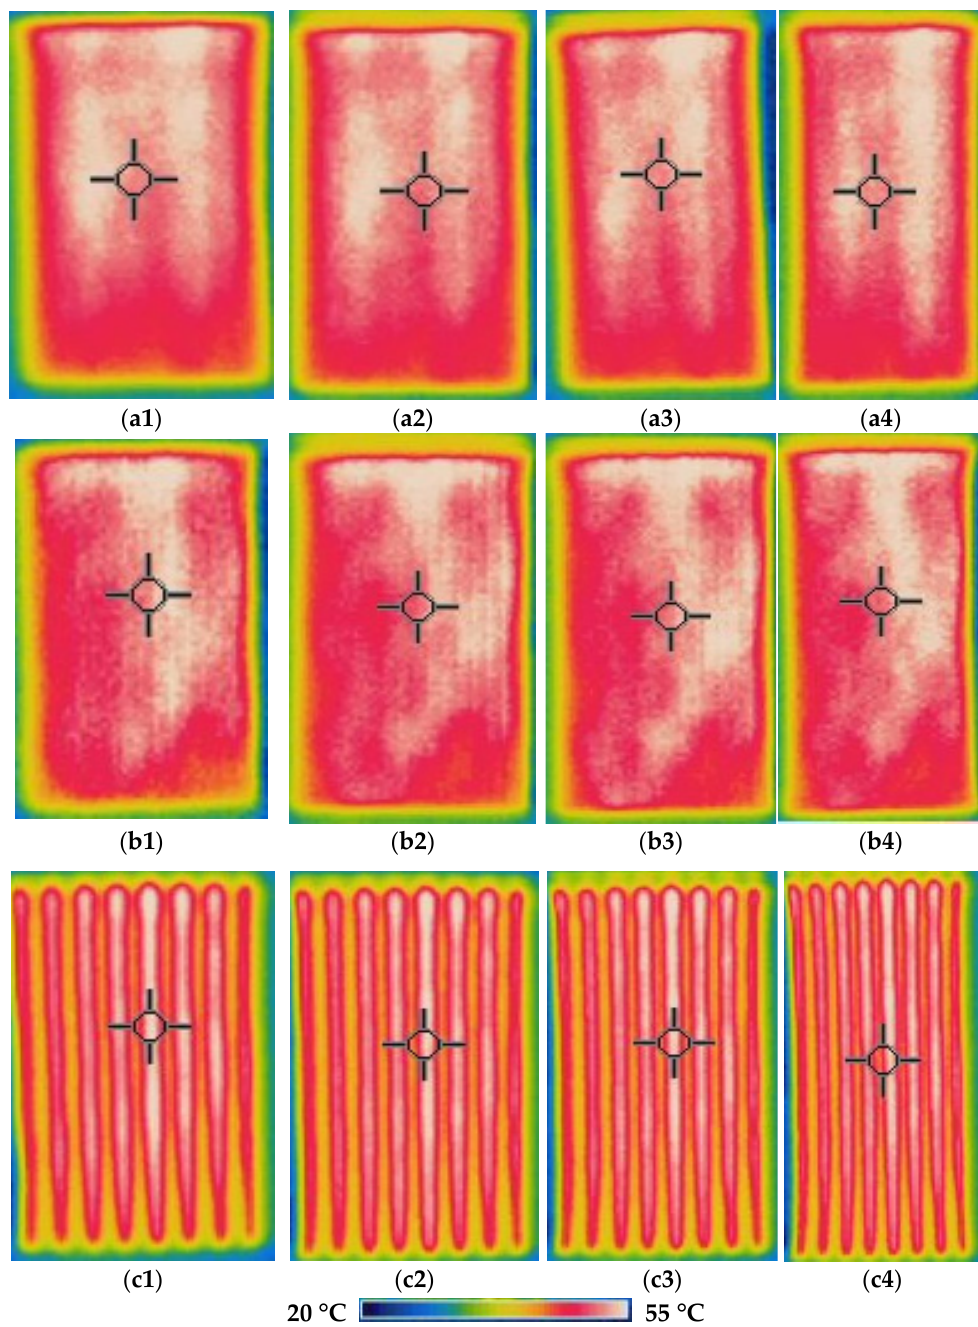
Figure 7. Thermal images of electro-conductive fabrics of CF_LY group after 600 s of 2.5 V application: infrared images at ( a1 ) non-stretched, ( a2 ) 10% stretched, ( a3 ) 15% stretched and ( a4 ) 20% stretched of CF_LY1 structured fabric; ( b1 ) non-stretched, ( b2 ) 10% stretched, ( b3 ) 15% stretched and ( b4 ) 20% stretched of CF_LY2 structured fabric; and ( c1 ) non-stretched, ( c2 ) 10% stretched, ( c3 ) 15% stretched and ( c4 ) 20% stretched of CF_LY3 structured fabric.